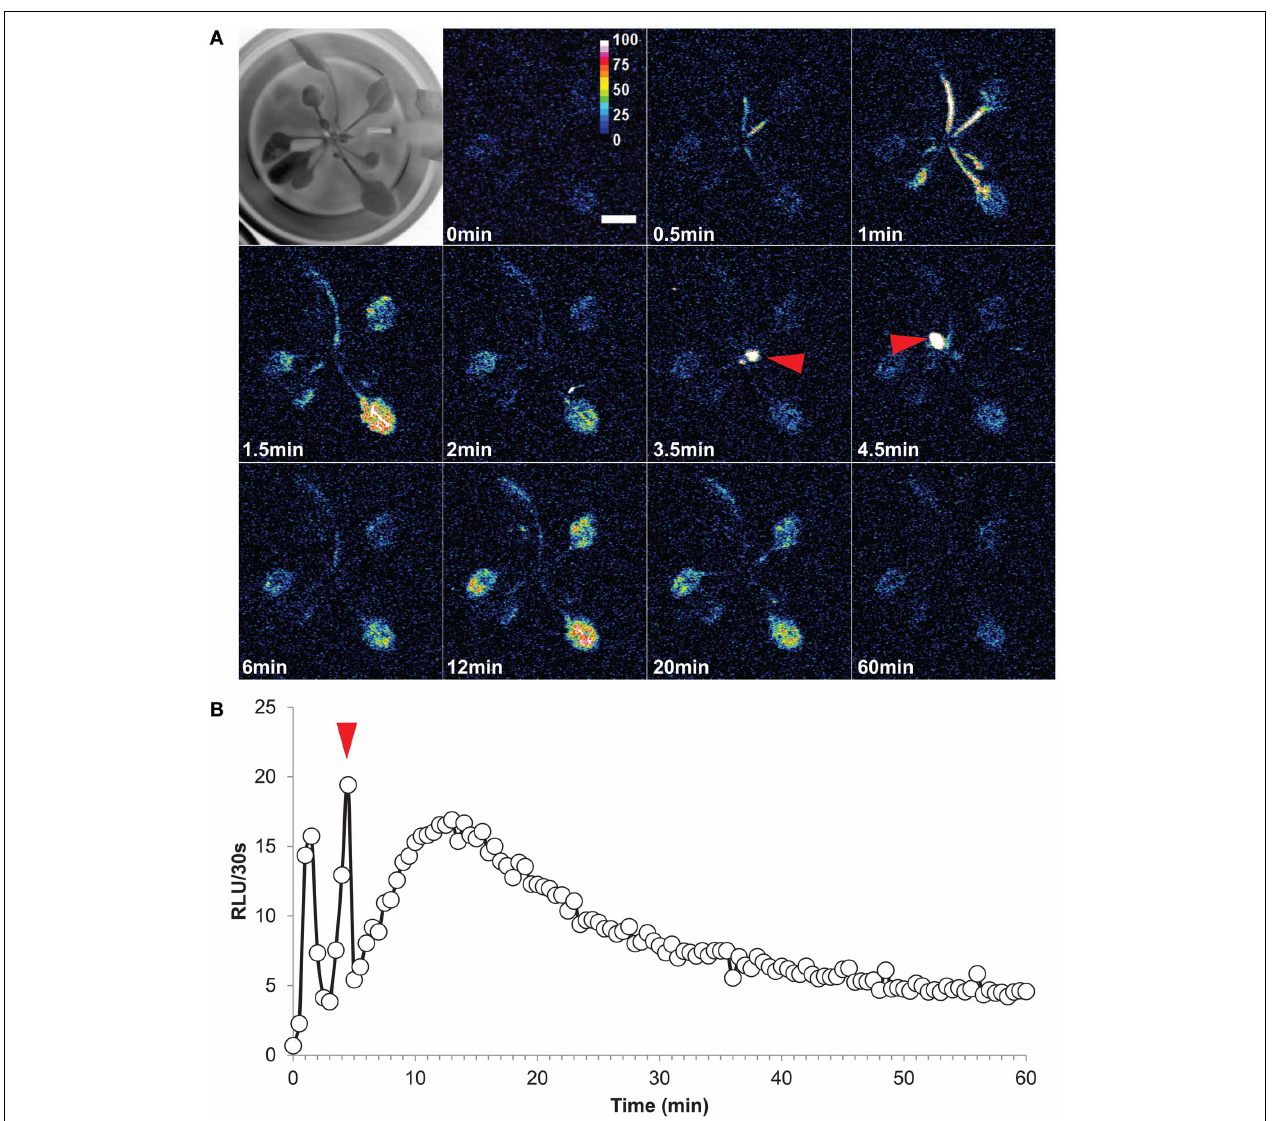
FIGURE 6 | High salt exposition of roots elicits long distance Ca 2 + dynamics in leaves. (A) Time series of images (time of capture indicated in the left bottom corner of each image) showing propagation of Ca 2 + elevation in aerial part of an intact plant (Representative result of five independent plants). First image of the series is a bright-field view of the plant. At time = 0, a solution of NaCl (200mM final concentration) was applied to roots and light subsequently emitted from